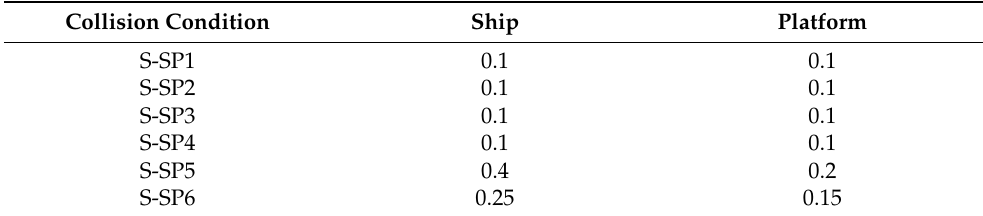
Table 7. The added mass coefficient under each collision condition.